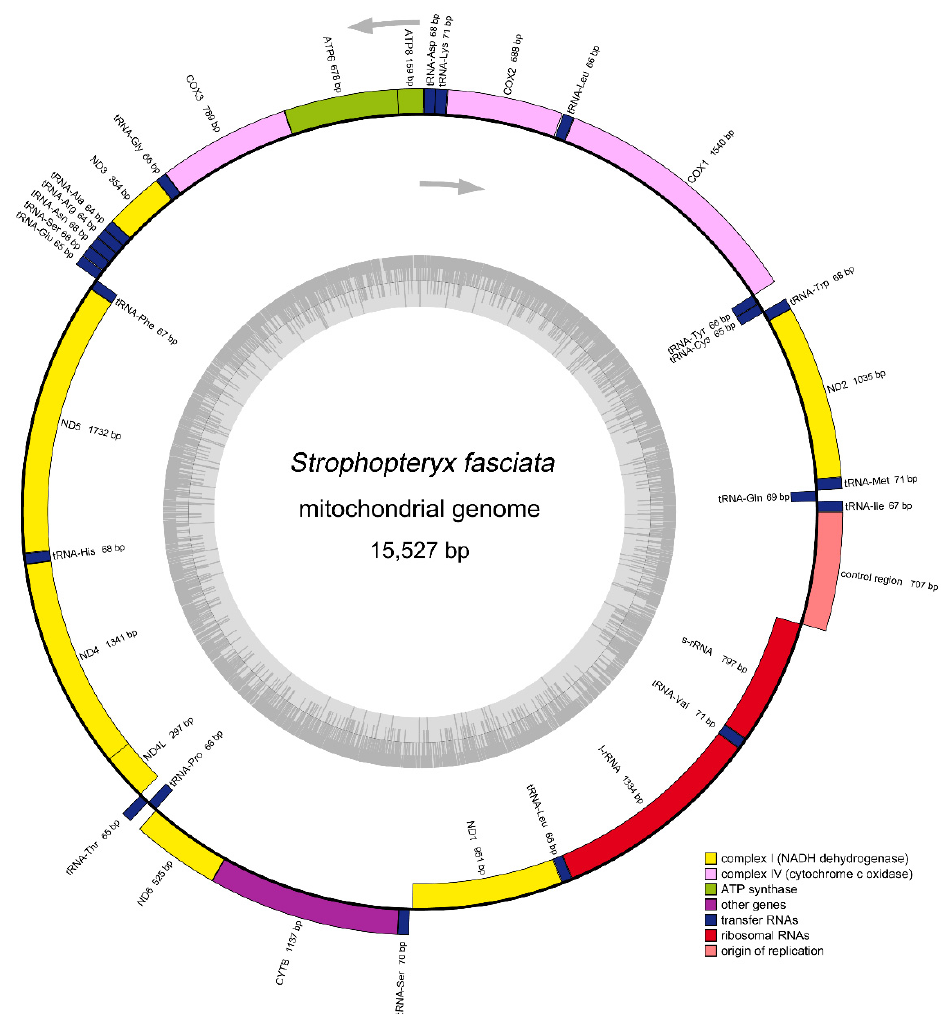
Figure 1. Circular map of the S. fasciata mitogenome. Genes shown on the inside of the map are transcribed in a clockwise direction, whereas those on the outside of the map are transcribed coun-